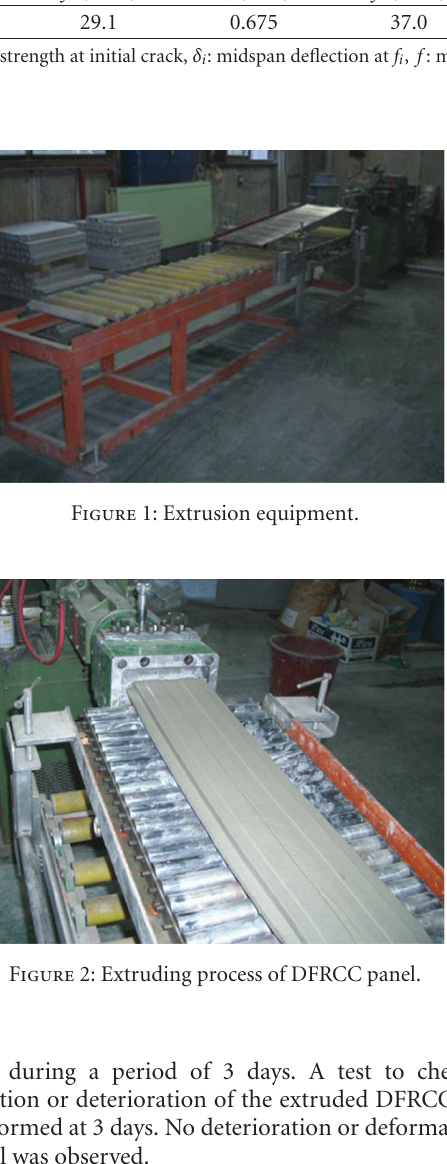
Figure 4: Flexural stress-deflection curves of extruded DFRCC pan-